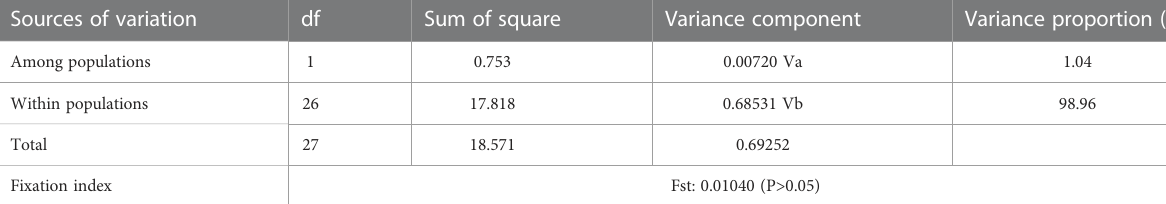
TABLE 5 AMOVA analysis of two C. tritonis populations base on COI gene sequences.